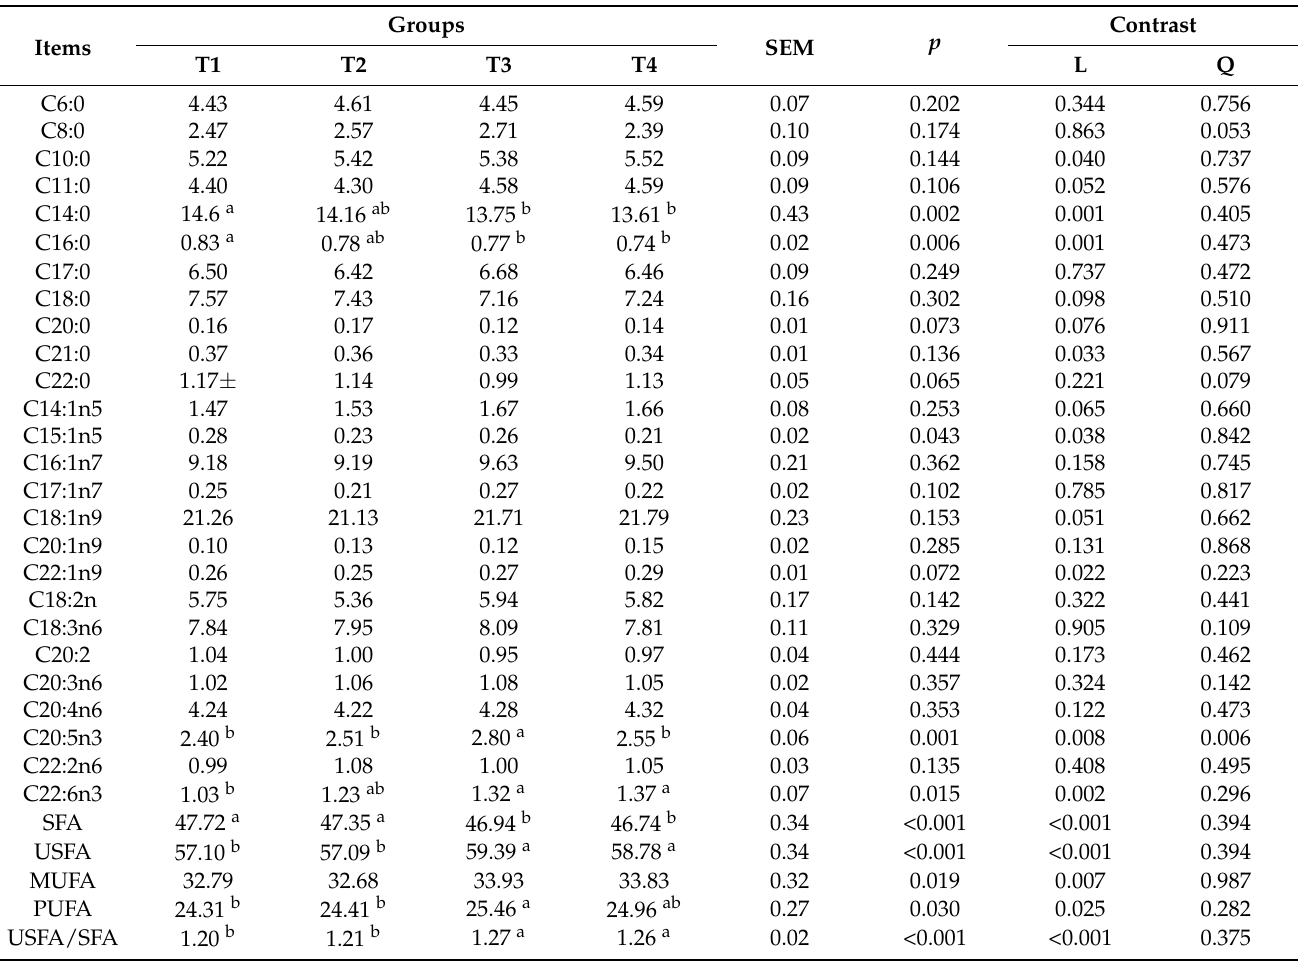
Table 4. Fatty acids profile in the thigh muscle of broilers